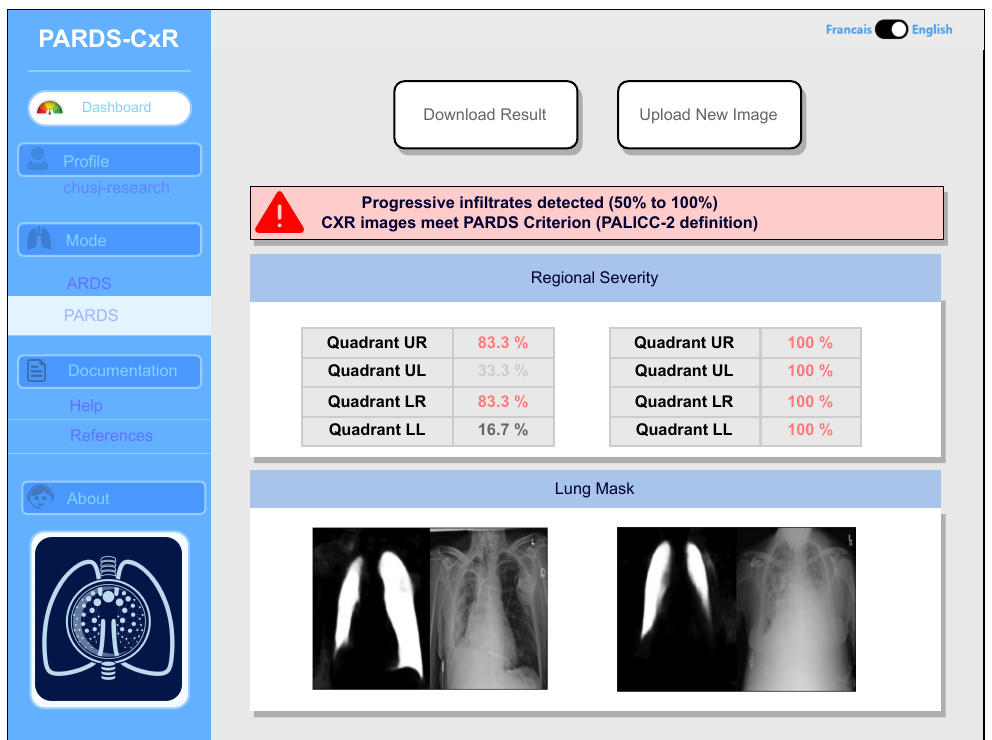
Figure 7. Main interface of the PARDS-CxR web application. In the standard mode, a single CXR image is analyzed according to the Berlin definition.